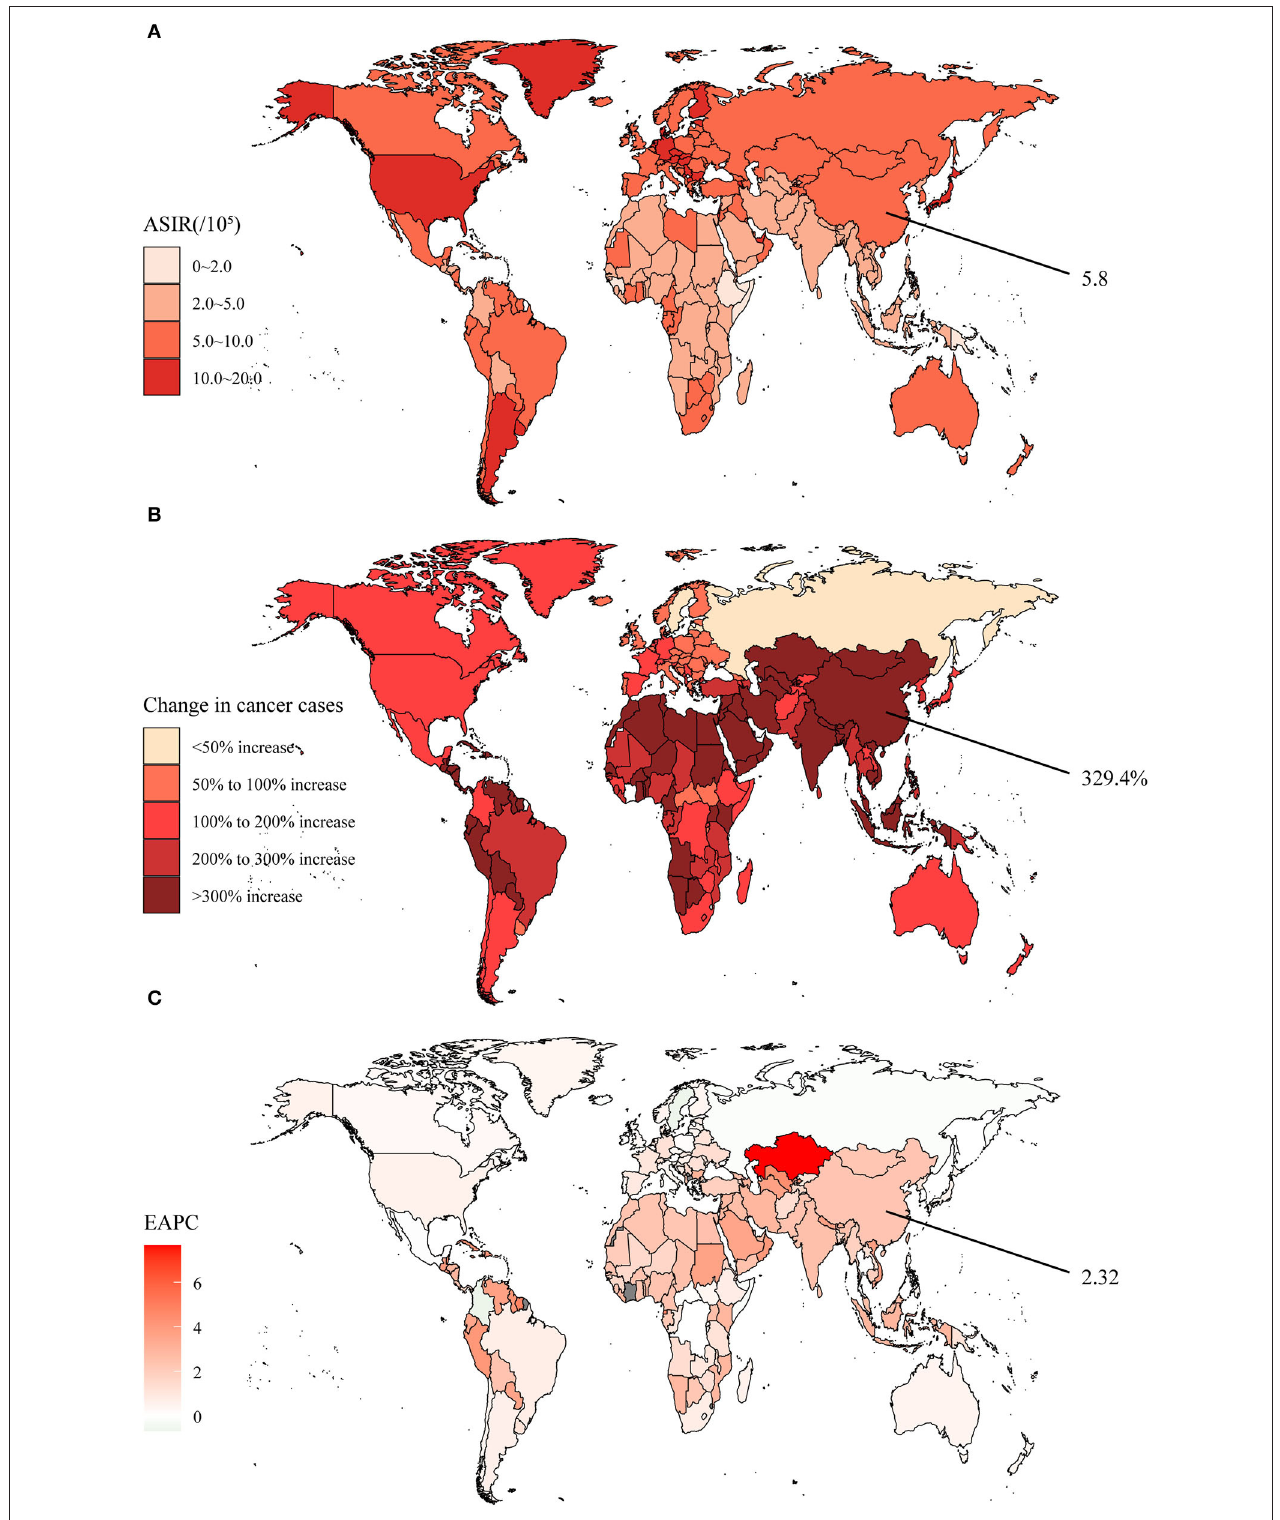
FIGURE 4 | The global disease burden of pancreatic cancer in 204 countries and territories. (A) The ASIR in 2019; (B) The relative change in incident cases between 1990 and 2019; (C) The EAPC of ASIR from 1990 to 2019. Outcomes of China were specifically annotated. ASIR, age-standardized incidence rate; EAPC, estimated annual percentage